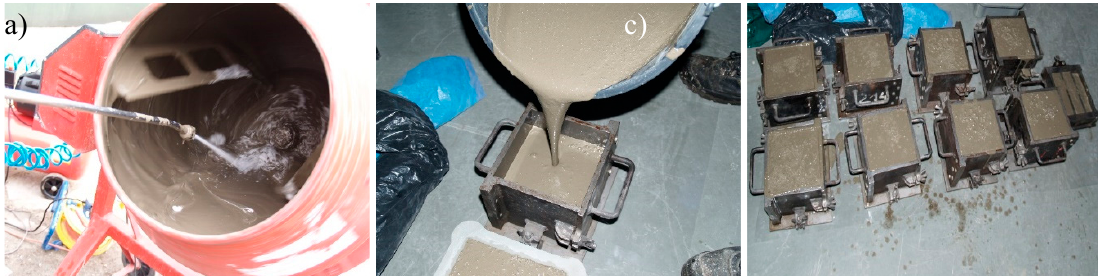
Figure 2. Preparation of samples: ( a ) adding foam; ( b ) pouring the mixture; ( c ) storage of samples.